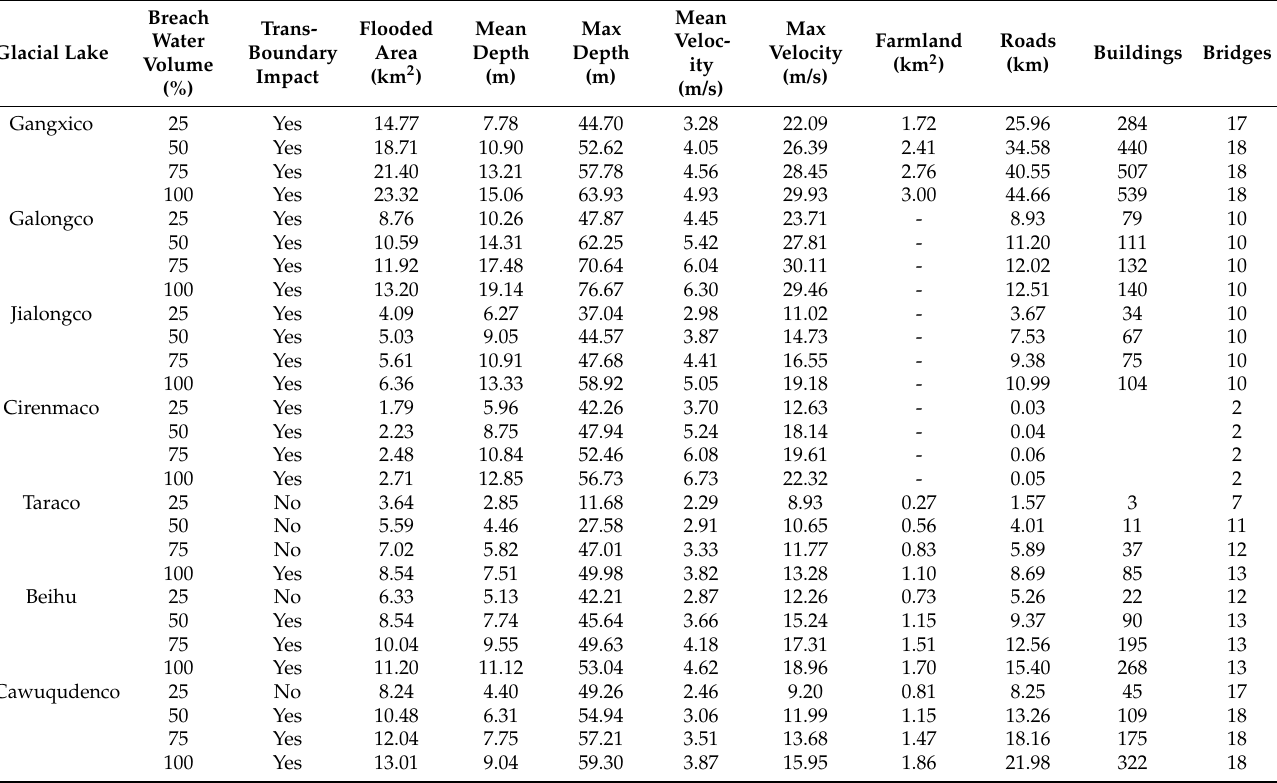
Table 4. Parameters of GLOFs originating in different glacial lakes and causing damage in the Chinese part of the Poiqu River